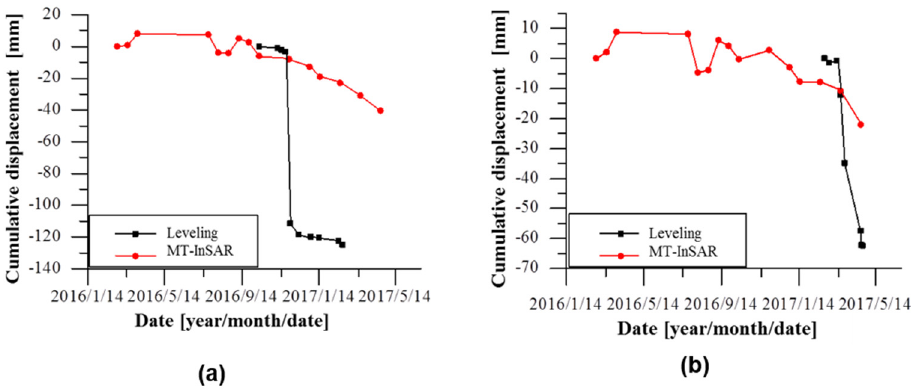
Figure 15. Comparison between MT-InSAR results from CSK and Levelling data: ( a ) P1; ( b ) P2.